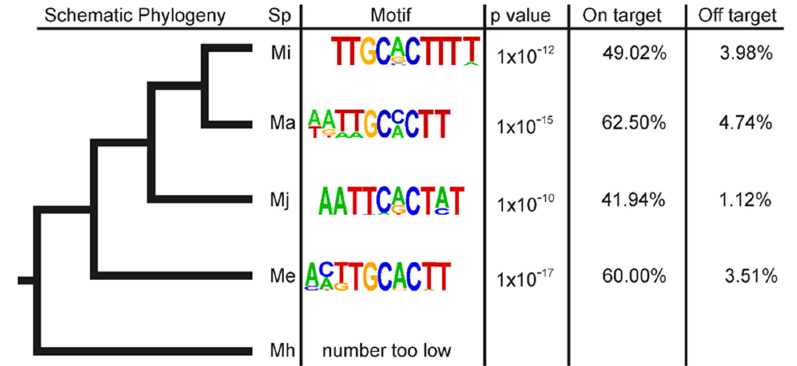
Figure 7. Independent identification of DG promoter motifs in the Meloidogyne genus. Left, a schematic representation of the phylogenetic relationship between M incognita (Mi), M. arenaria (Ma) , M. javanica (Mj), M. enterolobii (Me), and